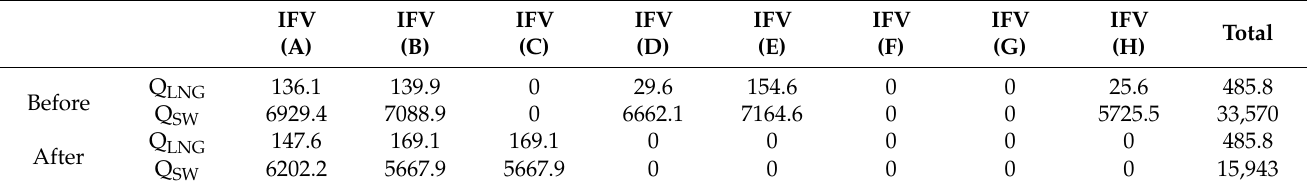
Table 3. IFV operation configuration scheme with a total treatment capacity of 462.3 t/h at a seawater temperature of 20 ◦